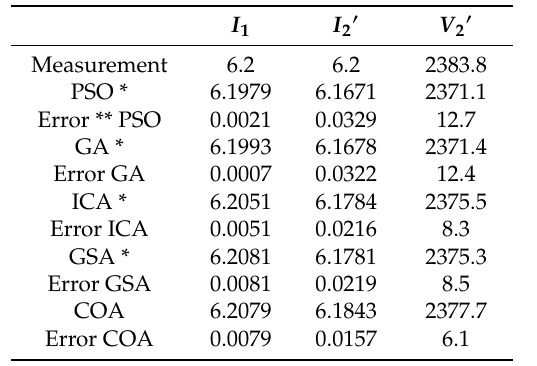
Table 3. Full load data for 15 kVA